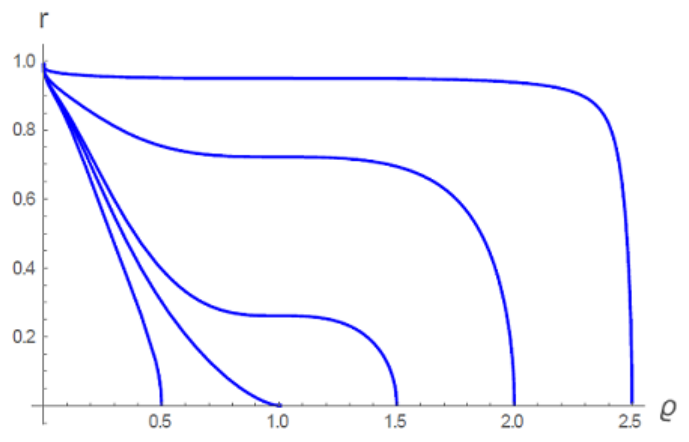
Figure 4. Gel density profiles, all at t = 1, but with differing choices of the free parameter (cid:36) 0 , the density at r = 0 [5].